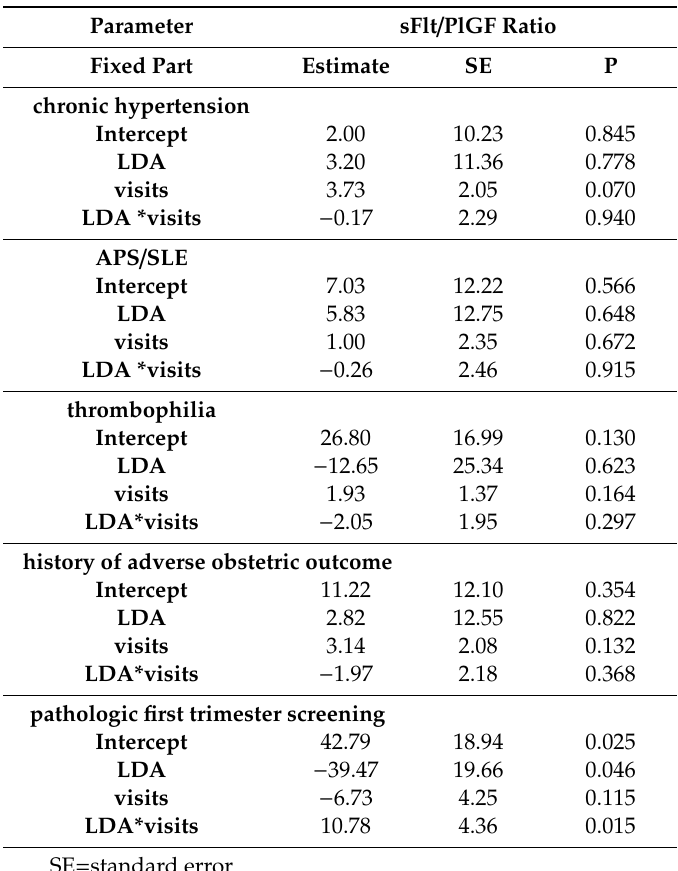
Table 6. Longitudinal changes of sFlt-1 / PlGF ratio during